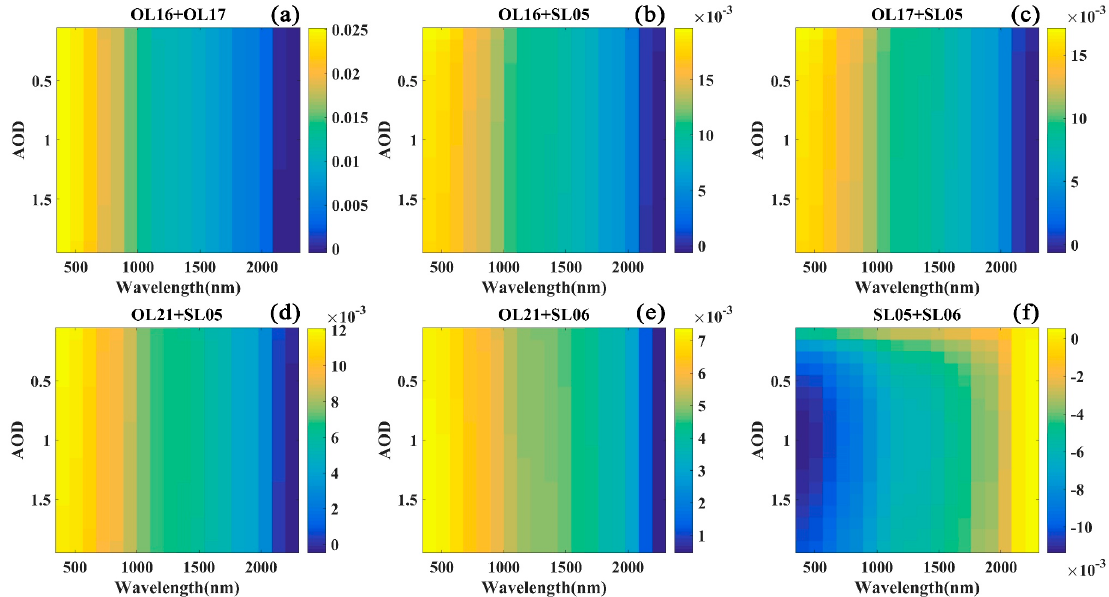
Figure 17. The differences between measured and theoretical aerosol reflectance, Δ ρ a , for the different band pairs via 6SV simulation. The x-axis represents the wavelength from 400 to 2250 nm. The color bar indicates Δ ρ a in sr − 1 . The y-axis represents the AOD, from 0.1 to 1.9, with an interval value of 0.1. Table 3. The full-band average values of the MAPE, MRPE, and RMSE of the atmospheric correction